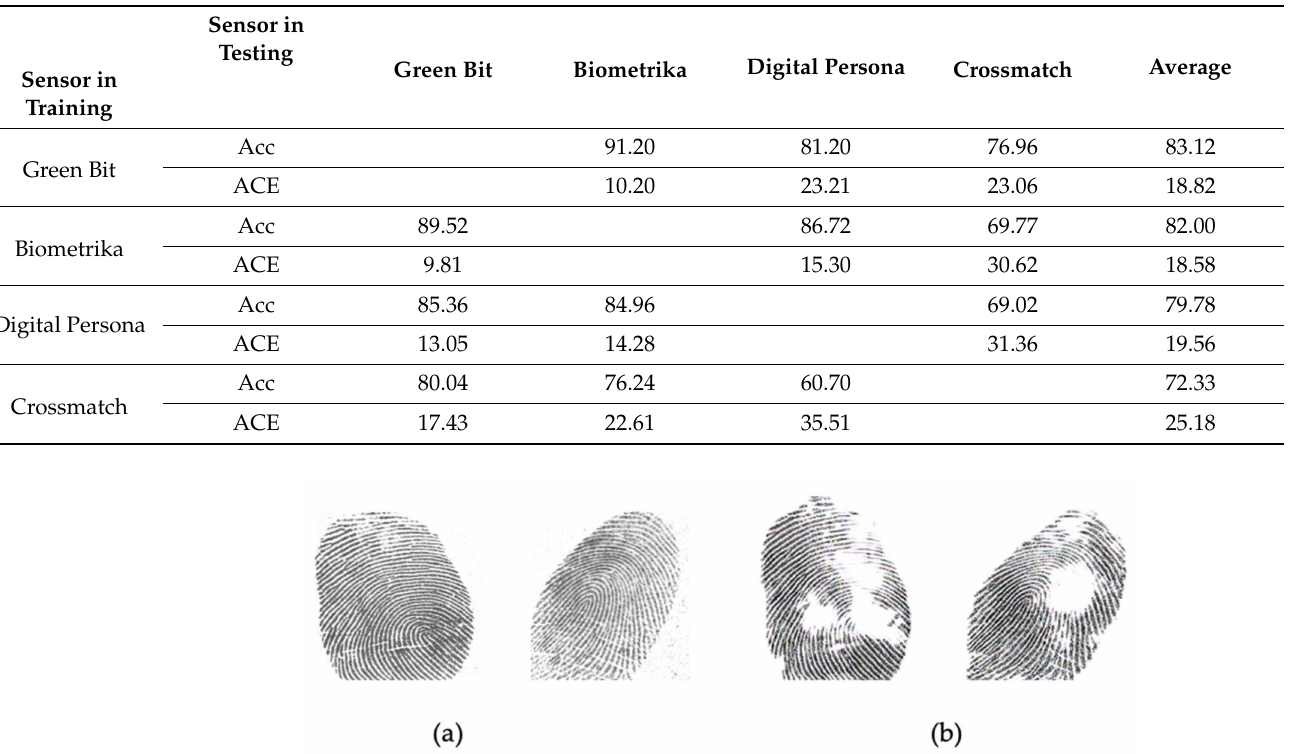
Table 5. The proposed network’s performance on LivDet 2015 in terms of classification accuracy (acc%) and average classification error (ACE).